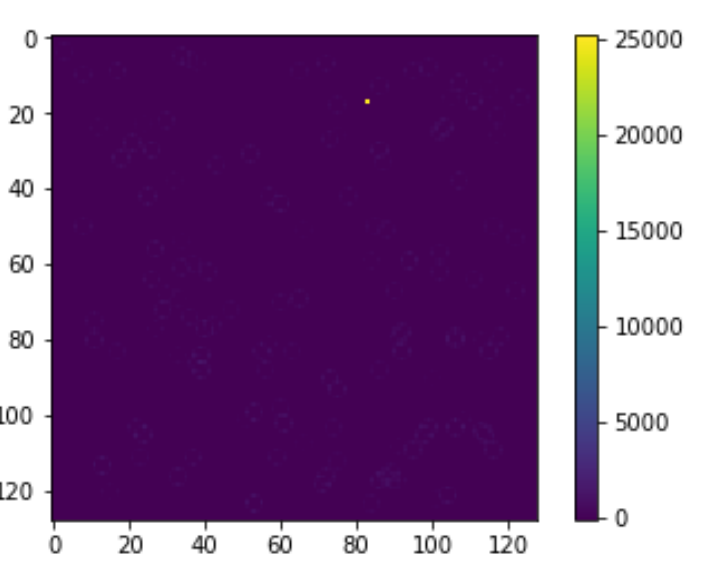
Figure 4. Sample differenced